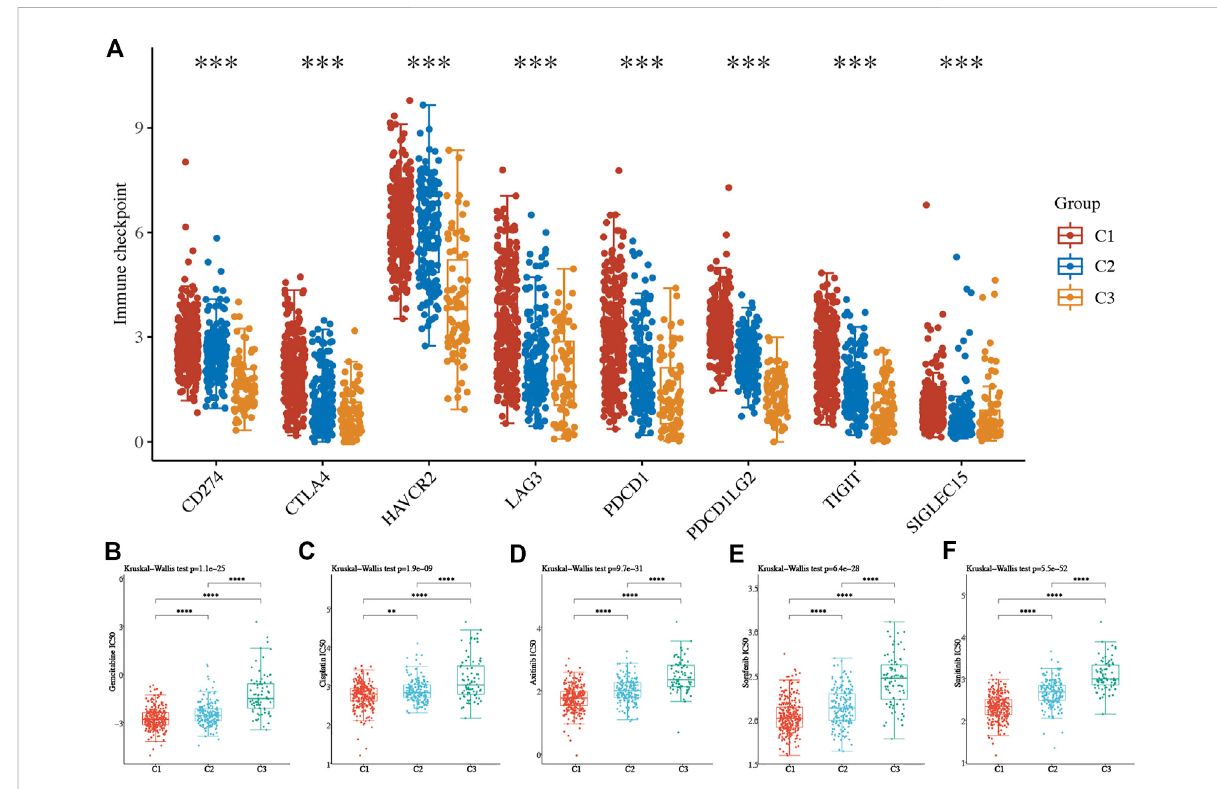
FIGURE 5 Difference of immune checkpoints and the IC 50 score in three subtypes of ccRCC. (A) Expression of immune checkpoints in three subtypes of ccRCC. (B – F) The IC 50 score of common drugs of each cluster of ccRCC patients. * p < 0.05; ** p < 0.01; *** p < 0.001; ccRCC, clear cell renal cell